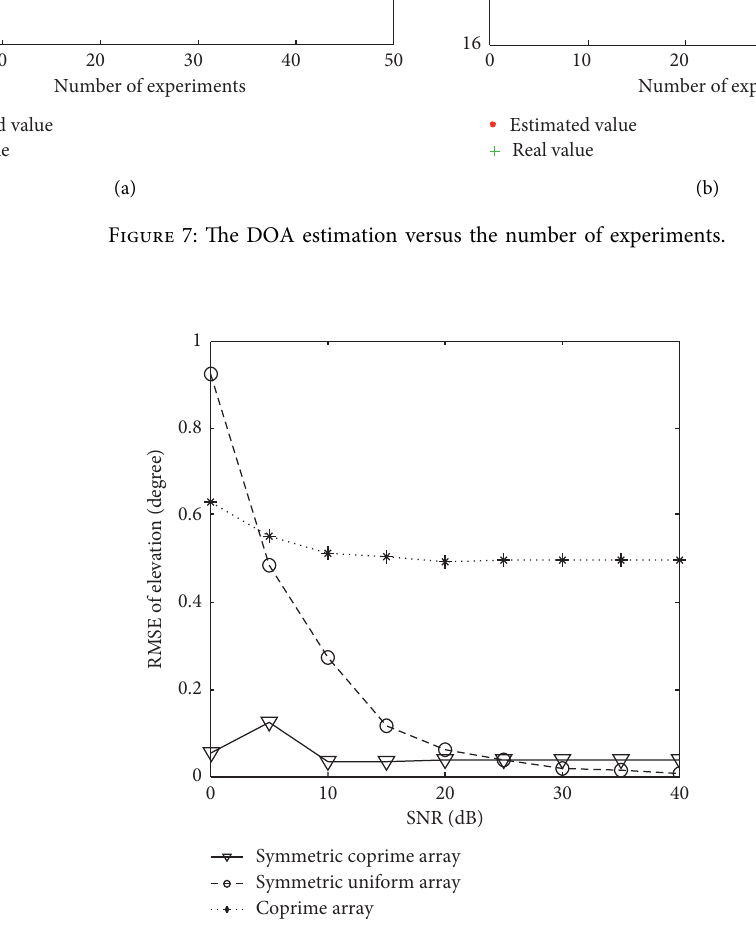
Figure 8: The RMSE of elevation versus